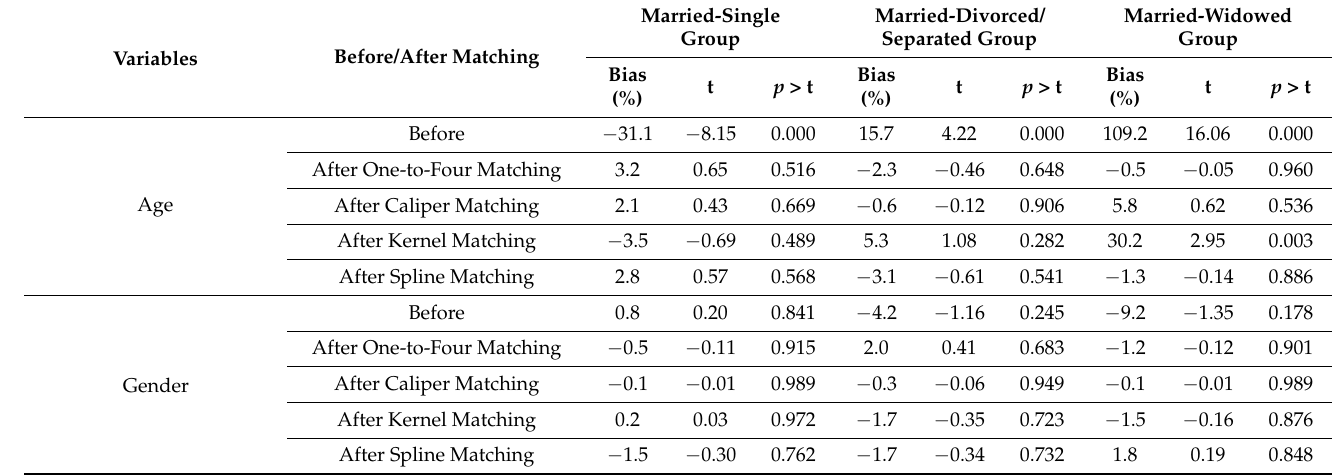
Figure A1. Kernel density functions of the treatment and control groups after caliper matching, kernel matching, and spline matching. ( a ) Married-Single Group (After Caliper Matching); ( b ) Married-Single Group (After Kernel Matching); ( c ) Married-Single Group (After Spline Matching); ( d ) Married-Divorced/Separated Group (After Caliper Matching); ( e ) Married-Divorced/Separated Group (After Kernel Matching); ( f ) Married-Divorced/Separated Group (After Spline Matching); ( g ) Married-Widowed Group (After Caliper Matching); ( h ) Married-Widowed Group (After Kernel Matching); ( i ) Married-Widowed Group (After Spline Matching). Table A2. The results of the balance